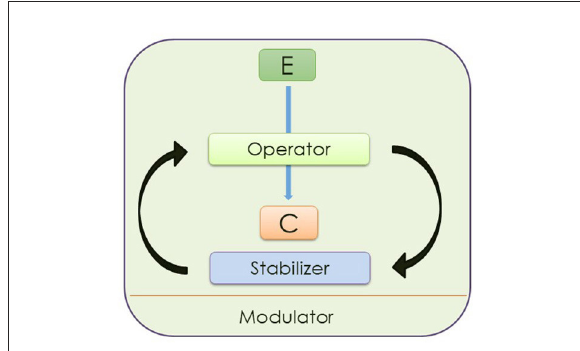
FIGURE1 The credition model describing the process of believing. The “Enclosure Function” (E) defines the enclosed representation of the perceived stimulus, the “Converter Function”(C) provides the appropriate action in response to the stimulus. By reinforcement learning the putative beliefs are stabilized which is indicated by the “Stabilizer Function.” These three supramodal functions are modulated by the internal state of the individual–called “Modulator Function.” In the figure the different type of the modulator function is indicated by a thin line. © HF Angel; conference presentation 2012, for the first time published in